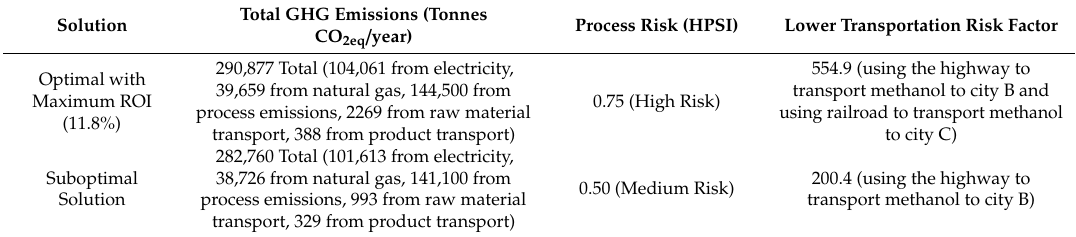
Table 6. Greenhouse gas (GHG) emissions and risk for the optimal and suboptimal